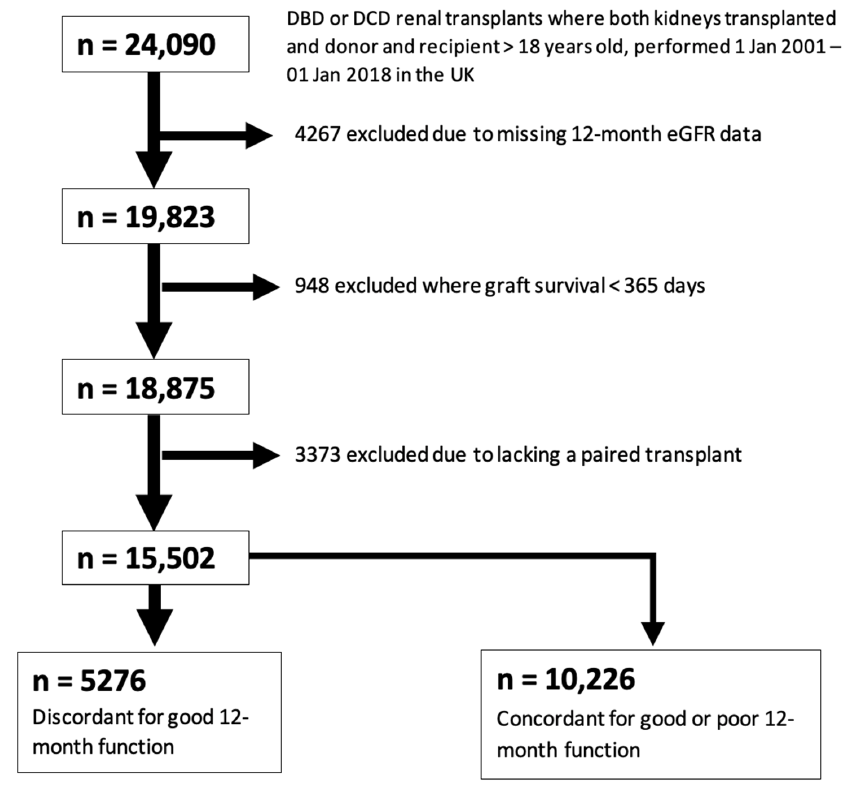
Figure 2. Study Population Selection (12-month eGFR).